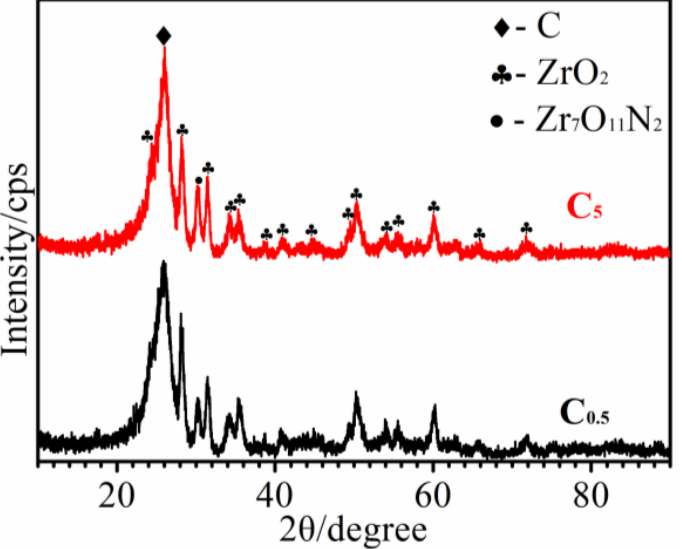
Figure 4. XRD patterns of the ablated C/C-SiC-ZrC under different loading spectrums. The surface central backscattered electron morphologies of the ablated